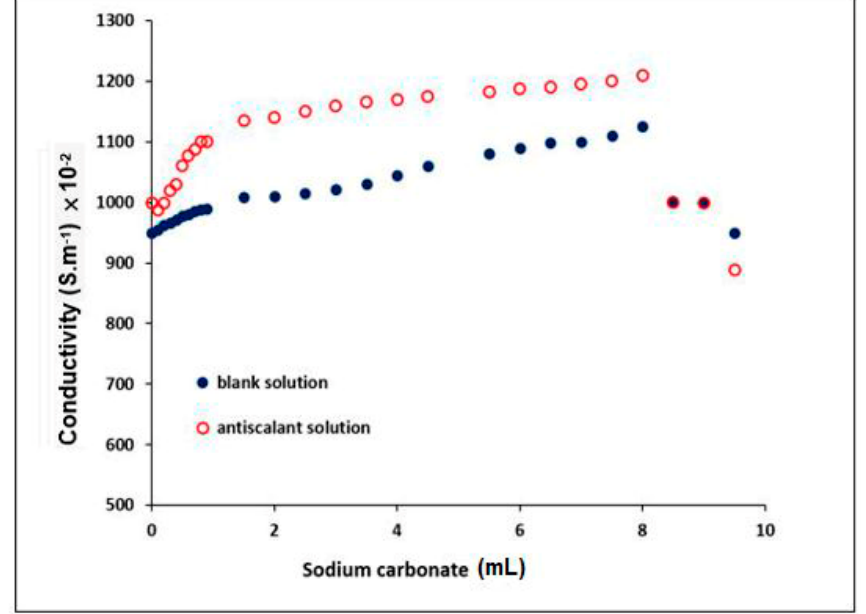
Figure 7. Variation in the conductivity in the presence and absence of 10 mg L − 1 of CA-co-GLC at 25 ◦ C and pH 7.5.